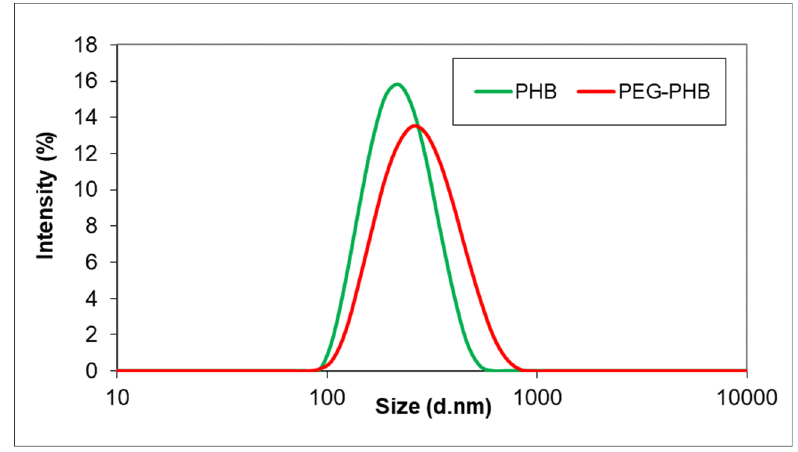
Figure 2. Size distribution of the PHB and PEGylated PHB nanoparticles.